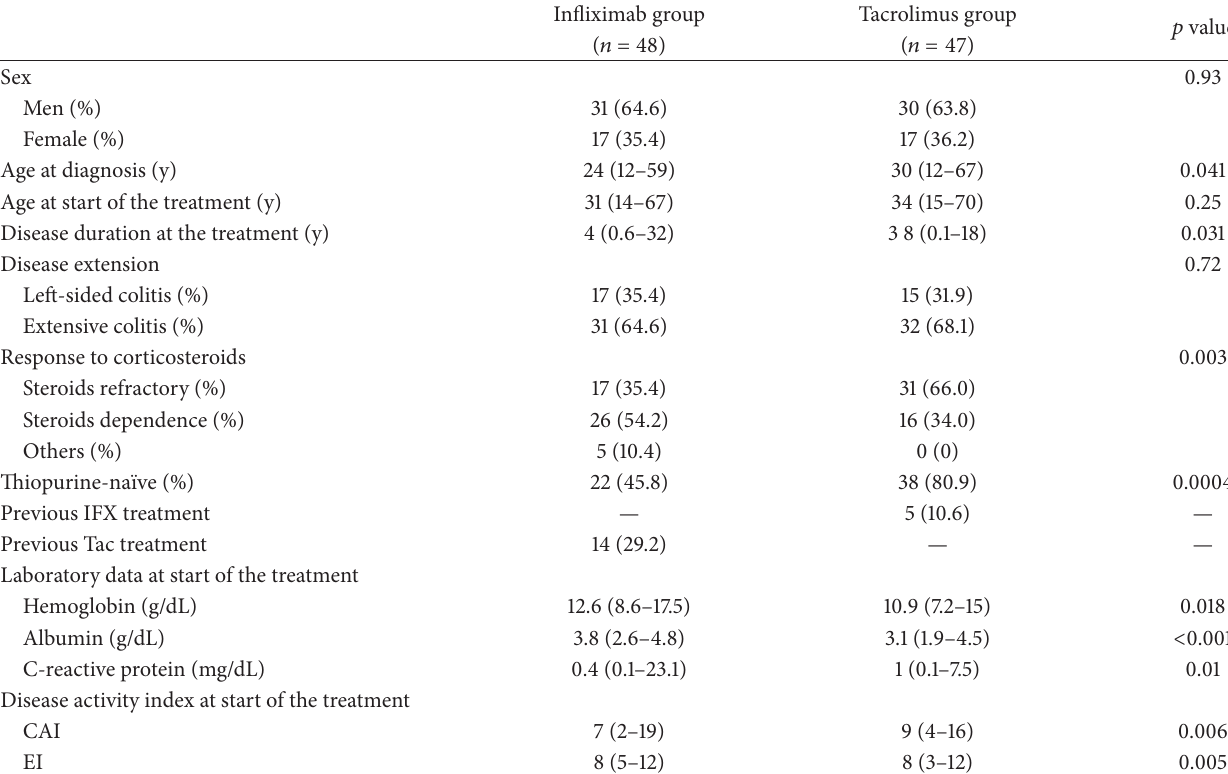
Table 1: Baseline characteristics of patients in infliximab group and tacrolimus